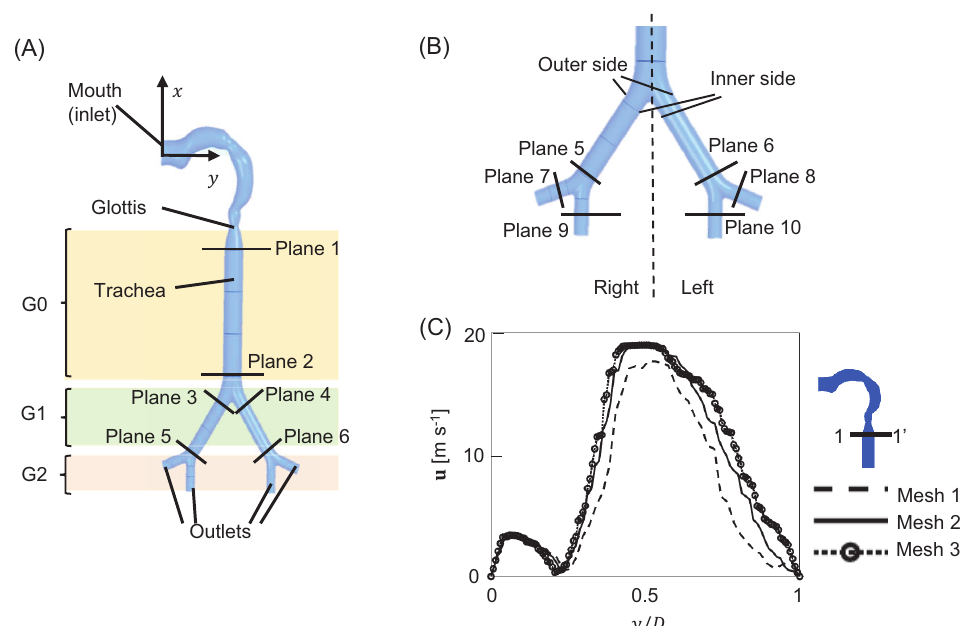
Figure 1. ( A ) Symmetric Weibel airway model with idealized mouth-to-glottis attachment. The coronal plane is defined along the x – y Plane at z = 0 m. Planes 1 and 2 comprise Generation 0 (G0), Planes 3–6 comprise Generation 1 (G1), and Planes 7–10 comprise Generation 2 (G2). See Table 2 for plane locations. ( B ) A magnified view of the bifurcations in G1 and G2 from Planes 5–10 is shown below, along with the anatomical left and right sides. + z -direction is into the page towards the dorsal (posterior) side; the − z -direction is out of the page towards the ventral (anterior) side. ( C ) 3D velocity ( u ) was extracted at the upper trachea (line 1-1’ at the coronal plane) and plotted as a function of non-dimensional diameter y / D for mesh independence tests (Table 1), where D = tracheal diameter = 18